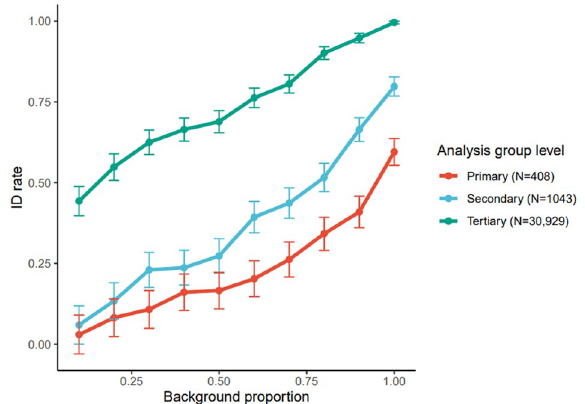
Figure 5. Average ID rate against background proportion for analysis using primary, secondary, and tertiary (product ID number) product groups with standard errors. 300 outbreaks for each data point are simulated as before, but instead of only using the product ID number as covariates, simulations were also run using the primary and secondary product groups for each registered purchase. The identification algorithm then attempted to return the relevant product